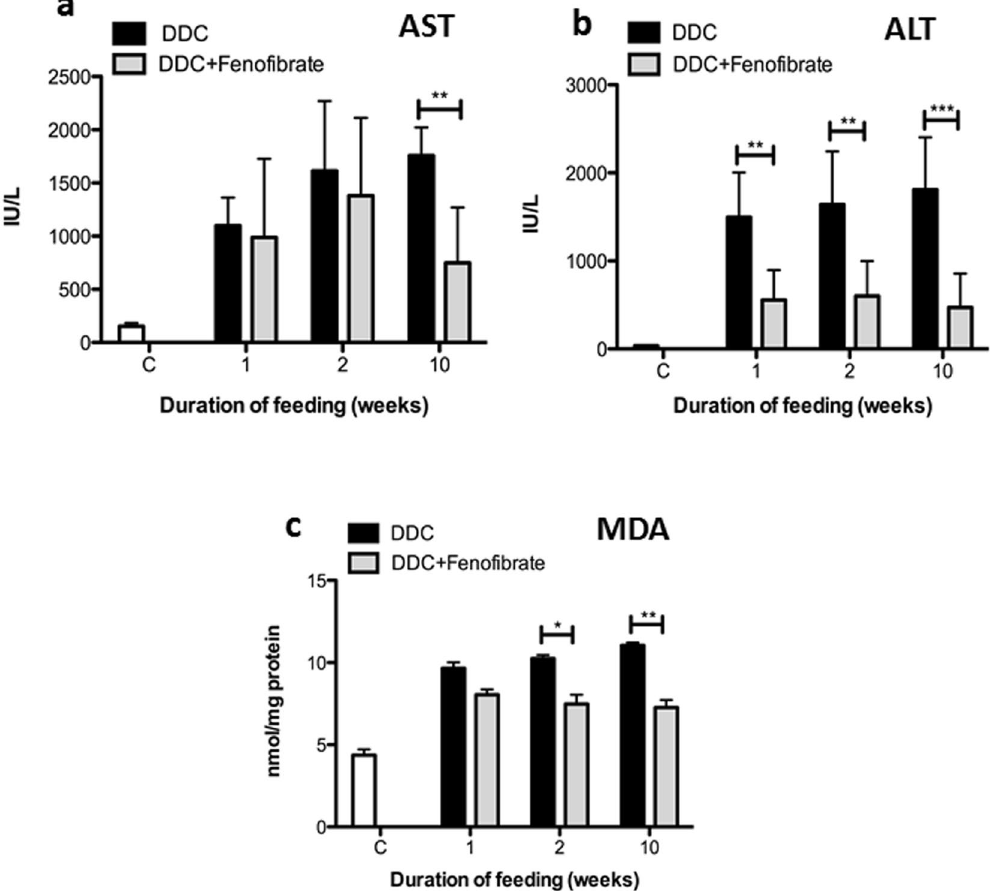
Figure 3. Fenofibrate prevents liver damage during DDC intoxication. Serum enzymes and liver tissue oxidative damage parameters. ( a ) Aspartic transaminase (AST); ( b ) alanine transaminase (ALT); ( c ) MDA- protein adduct levels (pmol/mg protein) in liver homogenates. Data are shown as mean ± SD collected from 5 animals per treatment group. Significances of DDC intoxication stages are shown versus DDC/fenofibrate co- administration: * p < 0.05; ** p < 0.01; *** p <